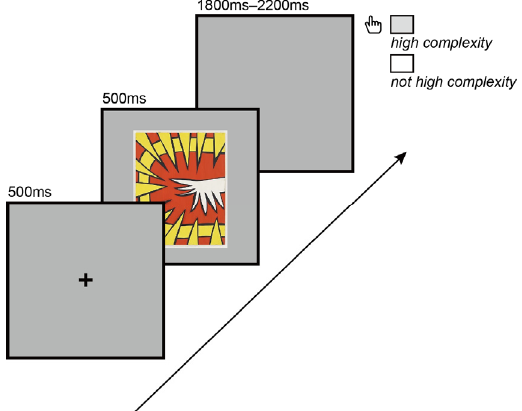
Figure 2. The experimental design of the task is shown in Figure 2. Each image in the task was presented for 500 ms. There was a random blank interval of between 1800 and 2200 ms between every two images to allow the participants to judge the image’s complexity. Participants were told to press the space bar when the image met the high-complexity condition in their expectations. If not, no response was required.